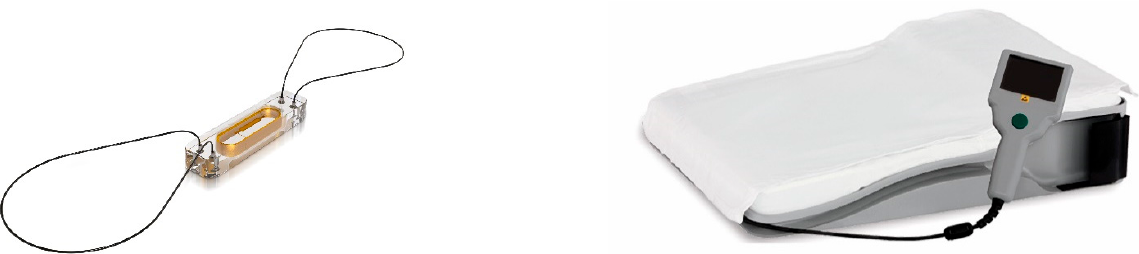
Figure 1. The CardioMEMS pulmonary artery pressure sensor and patient electronics unit for daily pressure measurements. Figures used with permission from Abbott (Abbott, Sylmar, CA, USA).